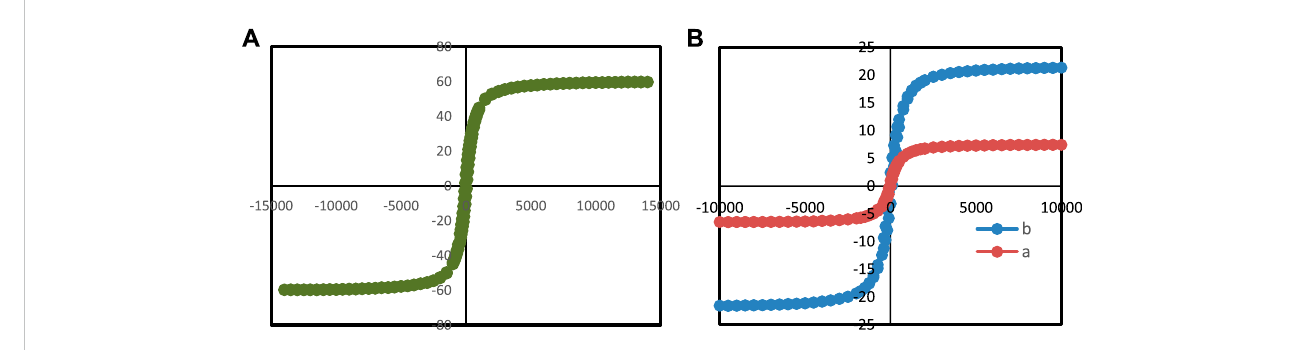
FIGURE 7 VSM analysis of (A) Ti 3 C 2 -Fe 3 O 4 @SiO 2 -FA, (B) (a) Ti 3 C 2 -Fe 3 O 4 @SiO 2 -FA-Cisplatin, and (b) Fe 3 O 4 @SiO 2